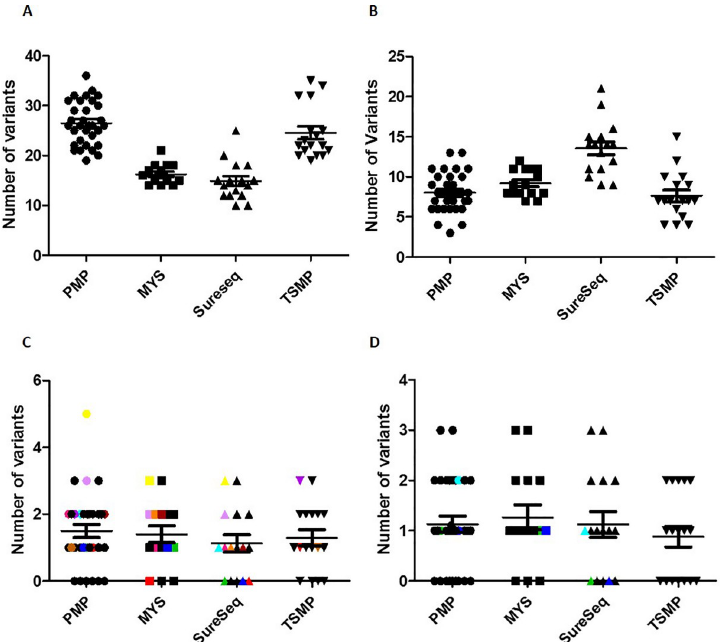
Fig 5. Number of variants called by panel. Each data point represents the number of variants called in each sample. A: Coding variants. B: Coding variants called in the core myeloid gene set. C: Clinically relevant variants. Coloured data highlight those patients with clinically relevant variants missed by any of the panels, either because those genes are not included in panel design, or because of panel issues. Each colour represents the same patient. D: Clinically relevant variants in the core myeloid gene set. Patients 7 (green), 14 (blue) and 16 (turquoise) are highlighted because they miss three clinically relevant mutations (one each).